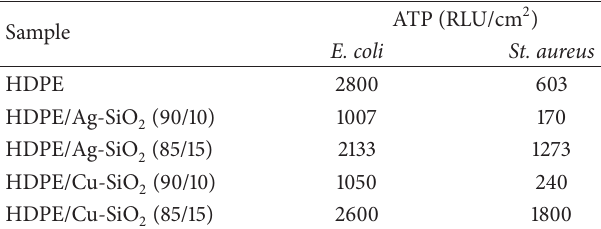
Table 9: Vitality of Salmonella typhimurium , Pseudomonas fluo- rescens and Burkholderia cepacia onto HDPE and the HDPE/Ag- (90/10) and HDPE/Cu-SiO SiO 2 mined using ATP method.